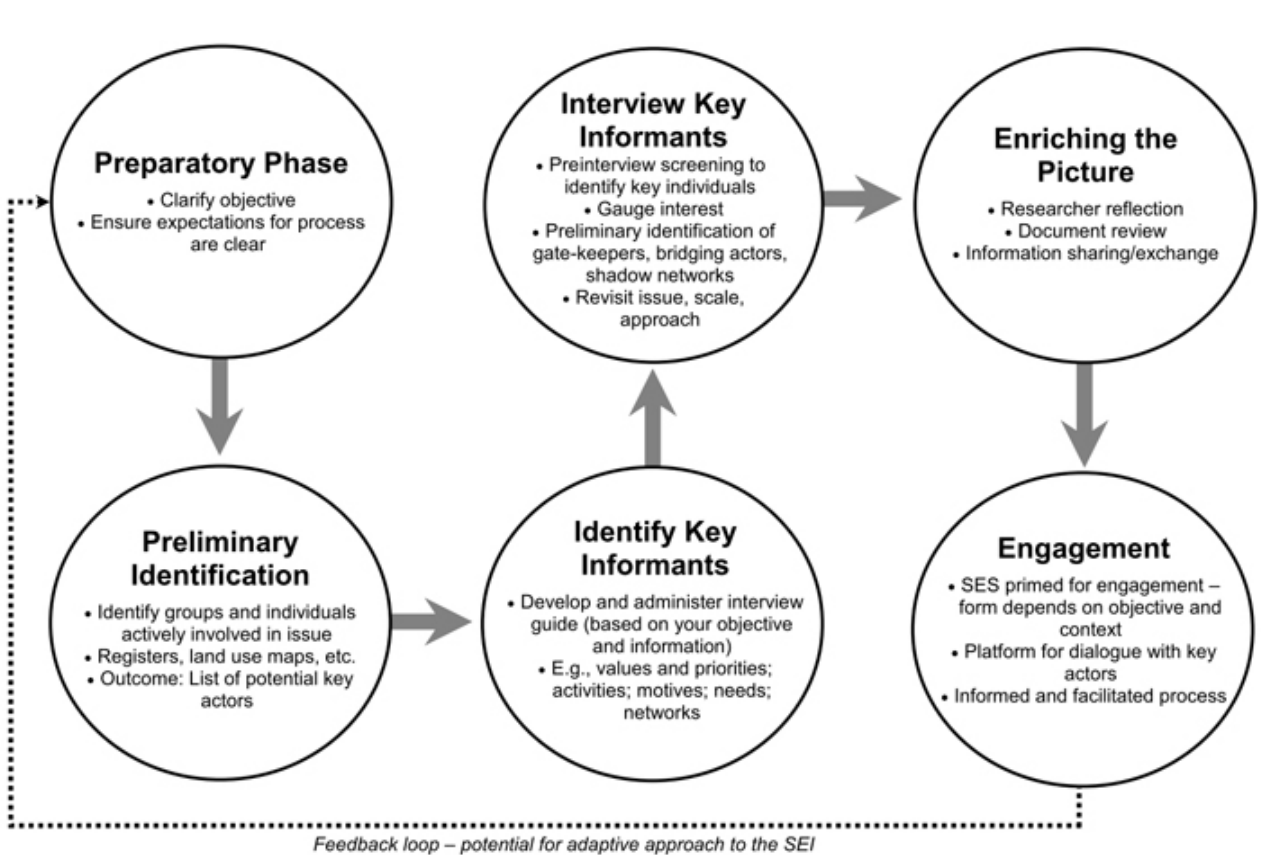
Fig. 1 . Phases of the social-ecological